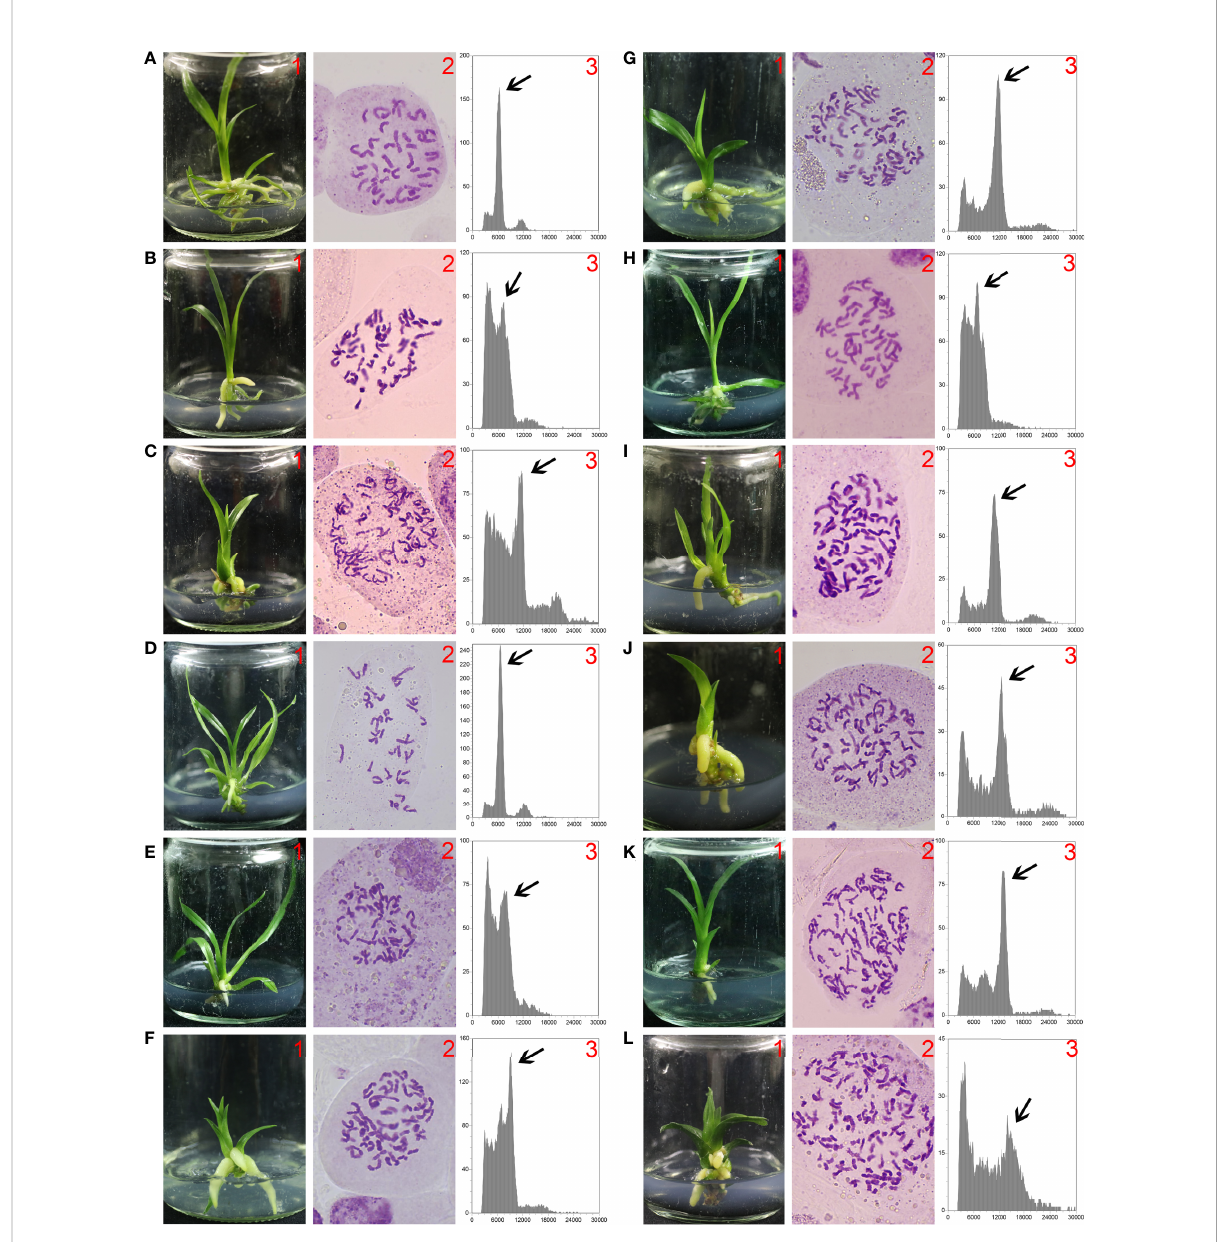
FIGURE 1 Ploidy identi fi cation of hybrid progenies. 1. In vitro cultured seedlings; 2. Chromosome numbers in a root tip cell; 3. Flow cytometry histogram of leaf tissue (arrow represents plant ploidy). (A) ‘ Xiaofeng ’ (diploid, 2 n = 2 × = 40). (B, C) Hybrid progenies of ‘ Yuchan ’ × ‘ Xiaofeng ’ : (B) ‘ 18-21-8 ’ (aneuploidy, 2 n = 50), (C) ‘ 18-21-10 ’ (aneuploidy, 2 n = 75). (D – G) Hybrid progenies of ‘ Xiaofeng ’ × ‘ Yuchan ’ where (D) ‘ 18-50-1 ’ (diploid, 2 n = 2 × = 40), (E) ‘ 18-50-86 ’ (aneuploidy, 2 n = 48), (F) ‘ 18-50-125 ’ (triploid, 2 n = 3 × = 60), and (G) ‘ 18-50-140 ’ (tetraploid, 2 n = 4 × = 80). (H – L) Hybrid progenies of ‘ Yuchan ’ × ‘ Huanghe ’ where (H) ‘ 18-24-50 ’ (aneuploidy, 2 n = 56), (I) ‘ 18-24-33 ’ (aneuploidy, 2 n = 72), (J) ‘ 18-24-15 ’ (tetraploid, 2 n = 4 × = 80), (K) ‘ 18-24-1 ’ (aneuploidy, 2 n = 93), and (L) ‘ 18-24-172 ’ (pentaploid, 2 n = 5 × =